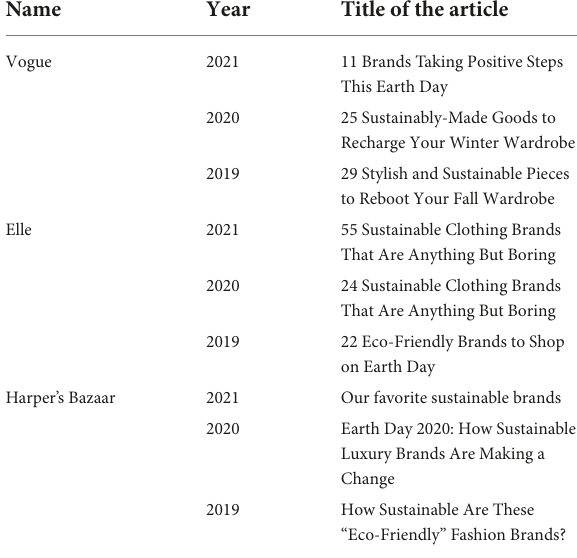
TABLE 2 Interview